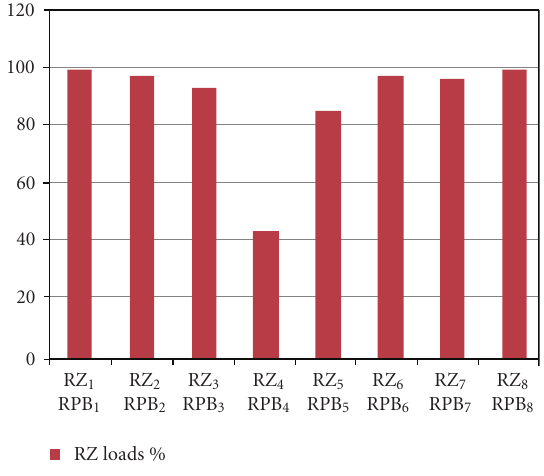
Figure 10: RZ workloads after task